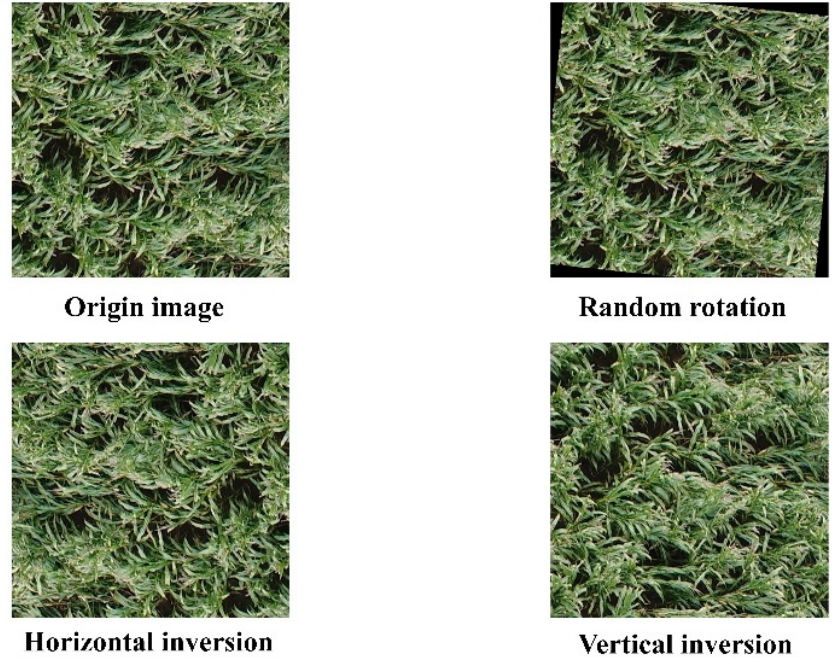
Figure 5. Original UAV image and three augmented images.